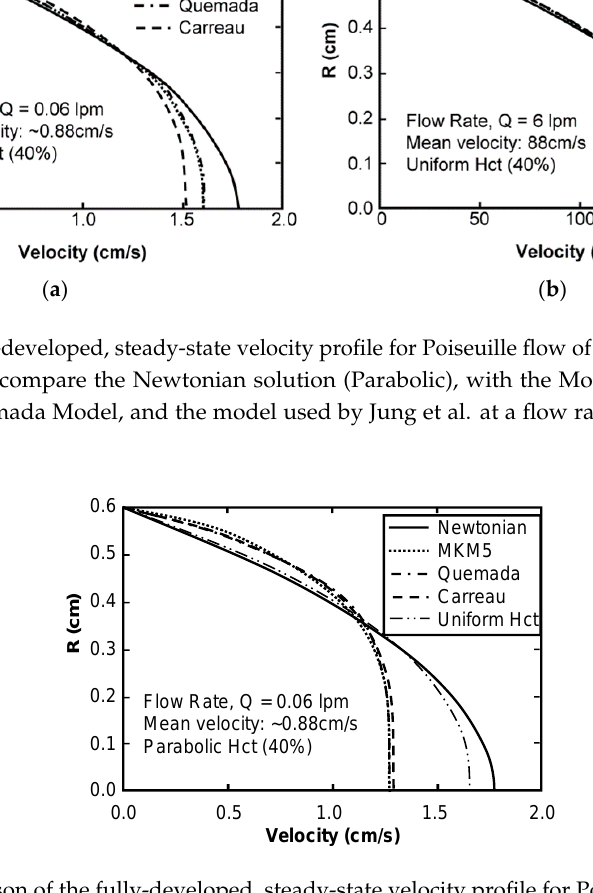
Figure 7. Comparison of the fully-developed, steady-state velocity profile for Poiseuille flow of blood assuming a parabolic hematocrit profile vs. a uniform profile. The results of the MKM5 model and Quemada model overlap.